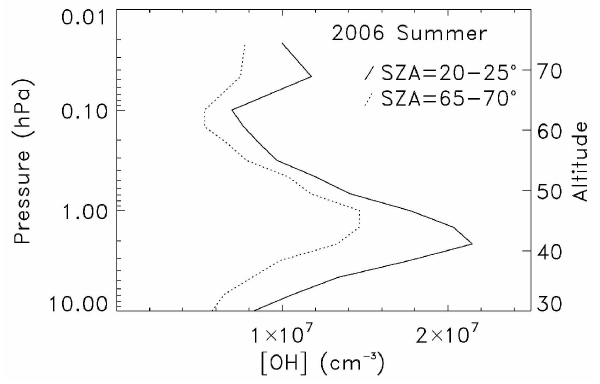
Fig. 2. Hydroxyl concentrations measured by MLS (points) at the 2.15hPa pressure level during July–September 2006, as a function of solar zenith angle. Morning values are shown to the left of the Figure 2: Hydroxyl concentrations measured by MLS (points) at the 2.15 hPa 0 ◦ line; afternoon values are to the right. Blue diamonds (red x’s) indicate mean values within 5 ◦ SZA bins for the morning (after- pressure level during July-September 2006, as a function of solar zenith angle. Morning noon), and the blue (red) curve shows the exponential function fit values are shown to the left of the 0 o line; afternoon values are to the right. Blue for morning (afternoon) as discussed in the diamonds (red x's) indicate mean values within 5 o SZA bins for the morning (afternoon), and the blue (red) curve shows the exponential function fit for morning (afternoon) as discussed in the text..